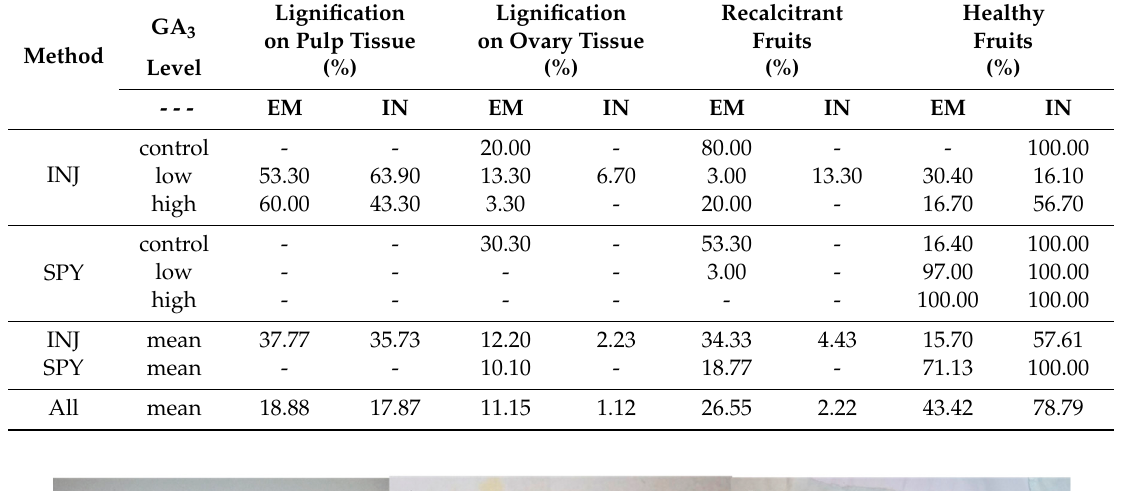
Table 2. Relative frequencies of harvested fruits and the related defects per combination treatment. Frequency is based on the observation of thirty floral buds per combination treatment.